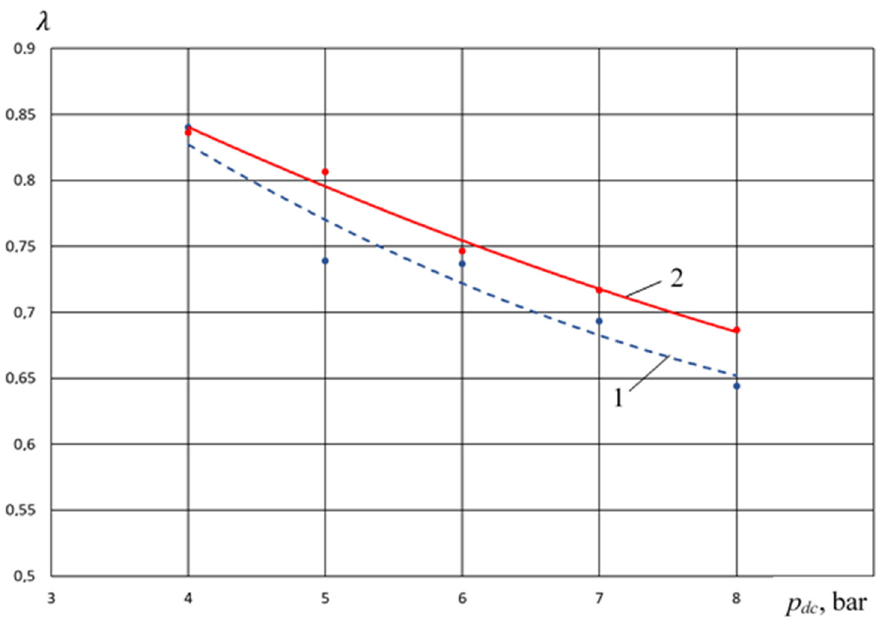
Figure 14. Dependence of the supply coefficient of the compressor section on the discharge pressure of the compressor section (1—Theory; 2—Experiment).